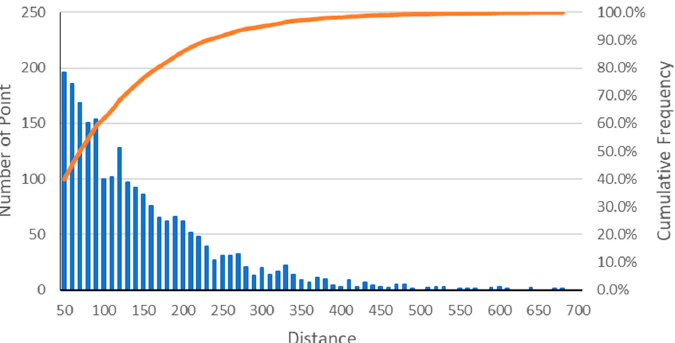
Table 3. Statistical parameters of the land–water boundary.